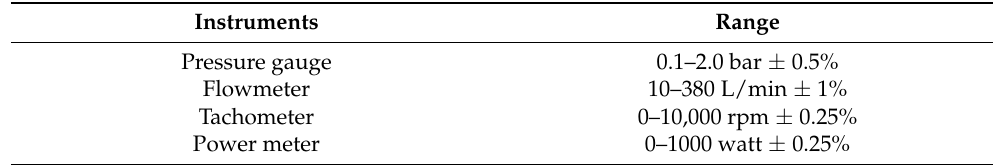
Figure 5. Centrifugal pump test rig. Table 3. Uncertainty analysis of instruments used in